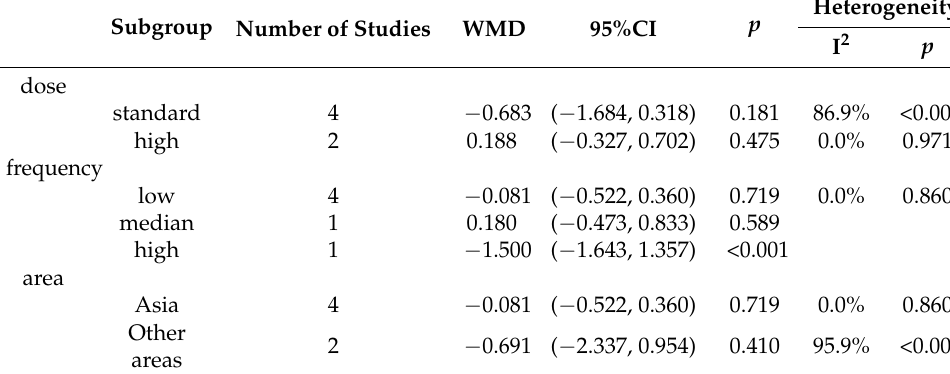
Table 4. Subgroup analyses—mean number of